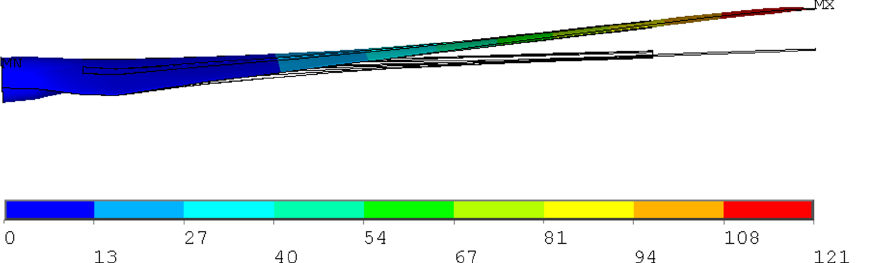
Figure 14. Total deformation of the RÜZGEM blade model vs. undeformed model under 100% extreme flapwise loading condition (scale factor: × 2).